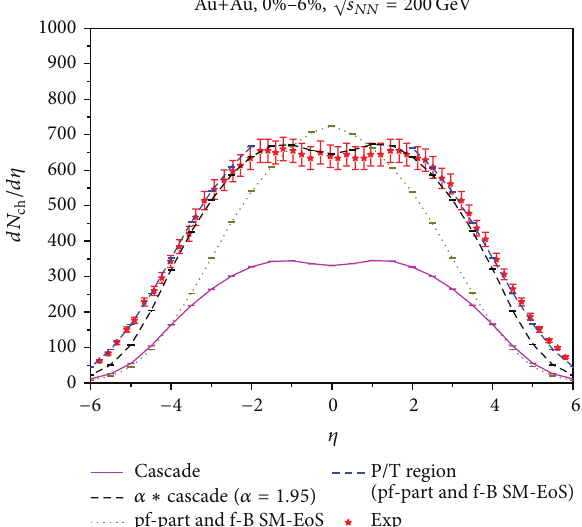
Figure 3: Charged particle pseudorapidity distributions for central Au+Aucollisionsat √𝑠 𝑁𝑁 = 200 GeV.Calculationswithcascadeand with potentials (“pf-part and f-B SM-EoS”) are shown by the curves. Experimental data taken from the PHOBOS collaboration [24] are represented by